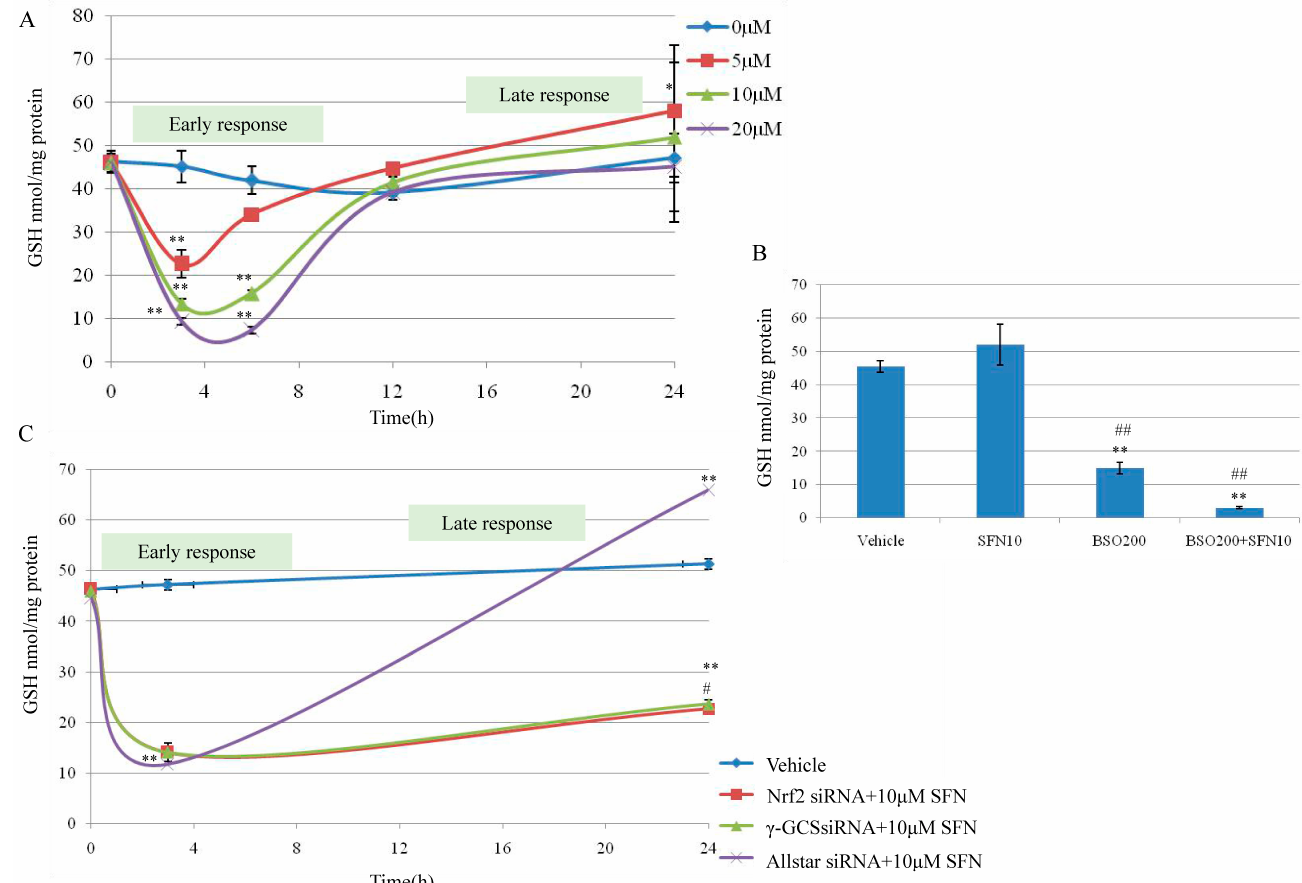
Figure 3. Effect of SFN on GSH synthesis by targeting Nrf2 and γ -GCS in T24 cells. ( A ) Cellular GSH concentrations in T24 cells exposed to SFN. Subconfluent T24 cells were treated with SFN 5–20 µM. At the indicated time (0–24 h), control cells and those treated with SFN 5–20 µM were derivatized and the samples analyzed by HPLC. The significant difference was reported * P < 0.05, ** P < 0.01. (B) Cellular GSH levels in T24 cells exposed to L-Buthionine-sulfoximine (BSO) and SFN. T24 cells were incubated with dimethylsulphoxide (DMSO , vehicle) as control, SFN 10 µM and BSO 200 µM in cotreatment and separately, for 24 h. GSH level was evaluated using HPLC method and has been expressed as nmol/mg of proteins. Significantly difference in GSH concentrations monitored in untreated cells (vehicle) , ** P < 0.01 ; significantly difference in GSH concentrations monitored in SFN treated cells, ## P < 0.01. ( C ) Effect of SFN (10 µM) treatment on GSH level in Nrf2 and γ -Glutamylcysteine Synthetase ( γ -GCS) suppressed T24 cells. T24 cells were treated with Nrf2 siRNA or γ -GCS siRNA, then treated with SFN (10 µM) for 3 h and 24 h. No transfected cells with DMSO (final concentration 0.1%) for 3 h and 24 h were used as a vehicle. Cells transfected with AllStar siRNA and then treated with SFN 10 µM for 3 h and 24 h were used as negative control. Results are mean ± SD of 3 samples. A significant change from basal level is indicated